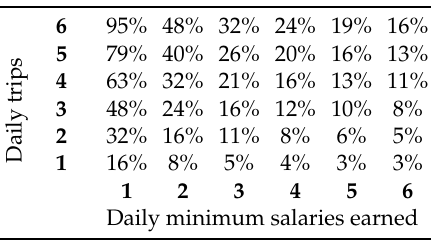
Table 4. Percentage of daily salary for every round trip on public transport.